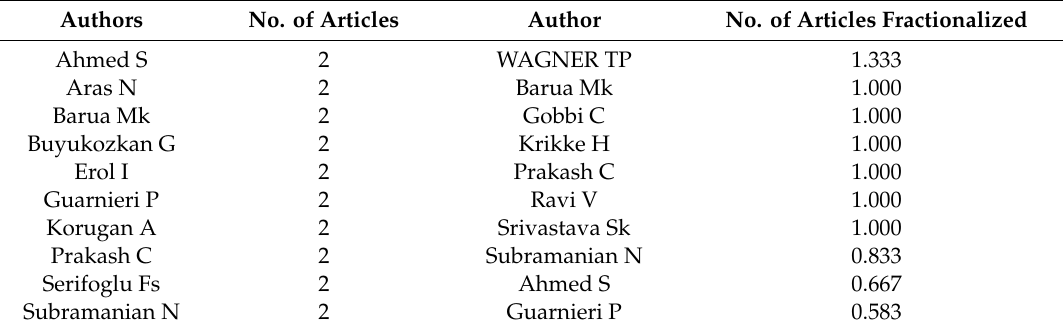
Table 1. Descriptive analysis: Top 10 most productive authors.